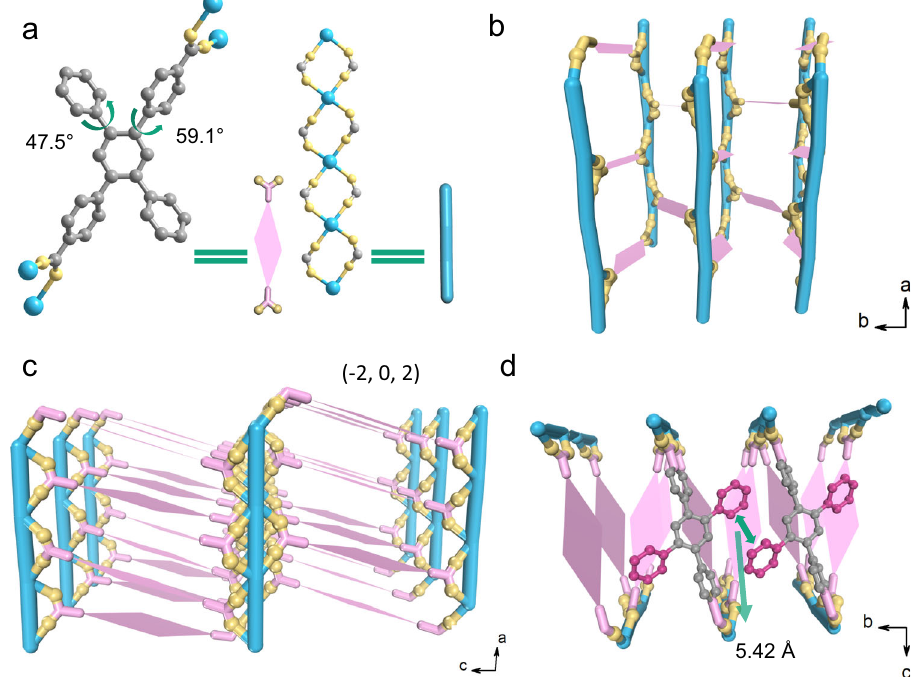
Fig. 1 The structure of FJI-H31. a Left: the coordinated ligand, right: the metal 1D chain. b View of FJI-H31 along the c axis. c View of FJI-H31 along the b axis. d View of FJI-H31 along the a axis. Color code: light blue, Gd; lemon, O; sliver,